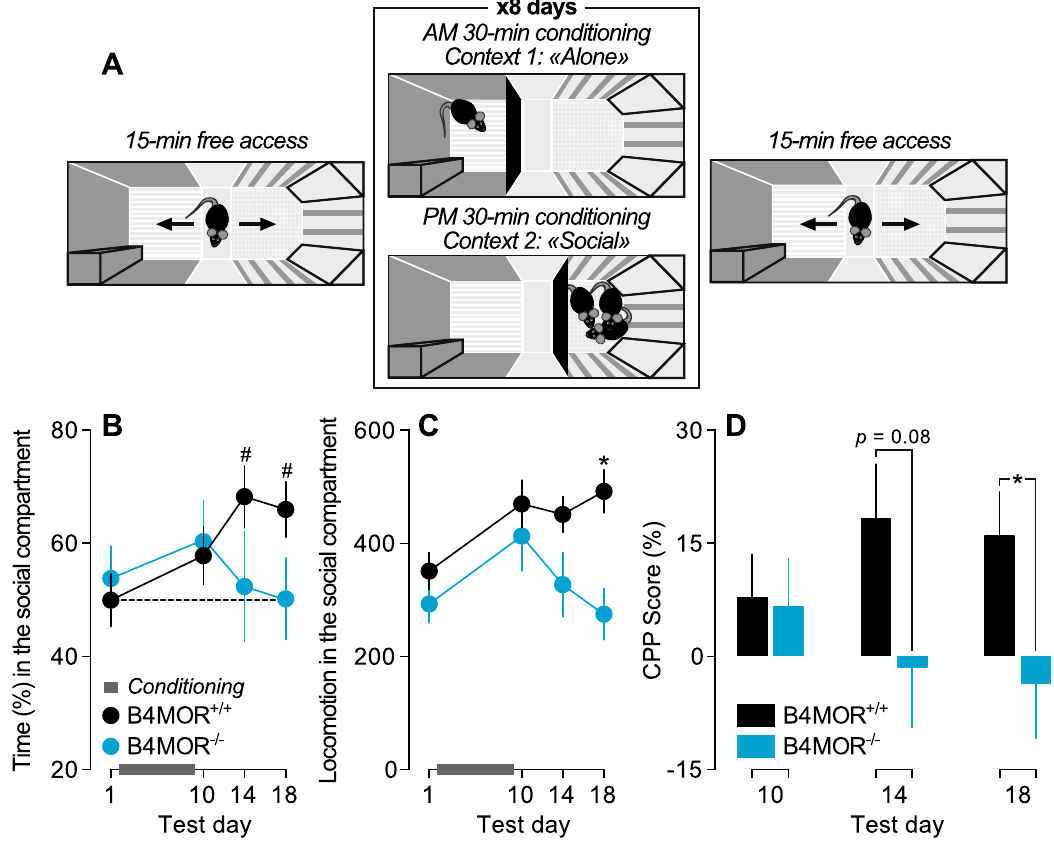
Figure 3. B4MOR −/− mice do not show conditioned place preference to social interactions. ( A ) shows a schematic representation of the social conditioned place preference paradigm. ( B ) The time spent in the social- paired compartment started at 50% in both genotypes on test day 1 and increased after social conditioning only in B4MOR +/+ mice. ( C ) Locomotor activity (beam breaks and release) in the social-paired compartment was higher in B4MOR +/+ mice versus B4MOR −/− mice after social conditioning. ( D ) CPP score was higher in B4MOR +/+ mice versus B4MOR −/− mice on test day 18. # P ’s < 0.05, versus Test Day 1. * P ’s < 0.05, B4MOR +/+ versus B4MOR −/− mice. N’s =